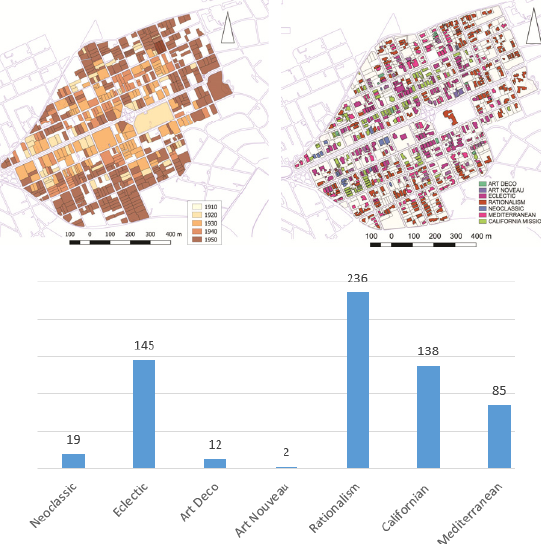
Figure 5. Consolidation of the District and diversity of architectural influences during the early